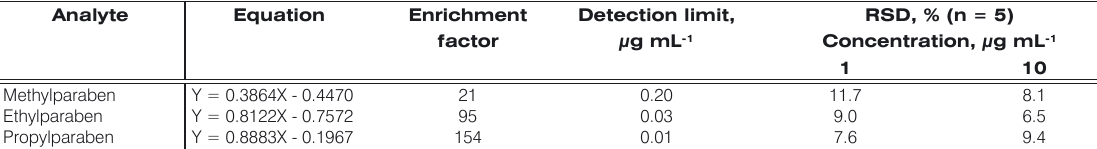
Figure 4. Chromatograms of (a) standard solution of parabens, (b) tap water, and (c) urine obtained after HFLPME. Peak identification: (1) internal standard tetradecane (50 µg mL -1 ), (2) methylparaben, (3) ethylparaben and (4) propylparaben. Concentration of each analyte in the standard solution is 1 µg mL -1 . NaCl concentration is 0.4 g mL -1 . Extraction time is 40 min. Solution stirring rate is 1500 rpm. For GC conditions see Section Table 1. Regression equations, enrichment factors, detection limits and reproducibilities of the method.